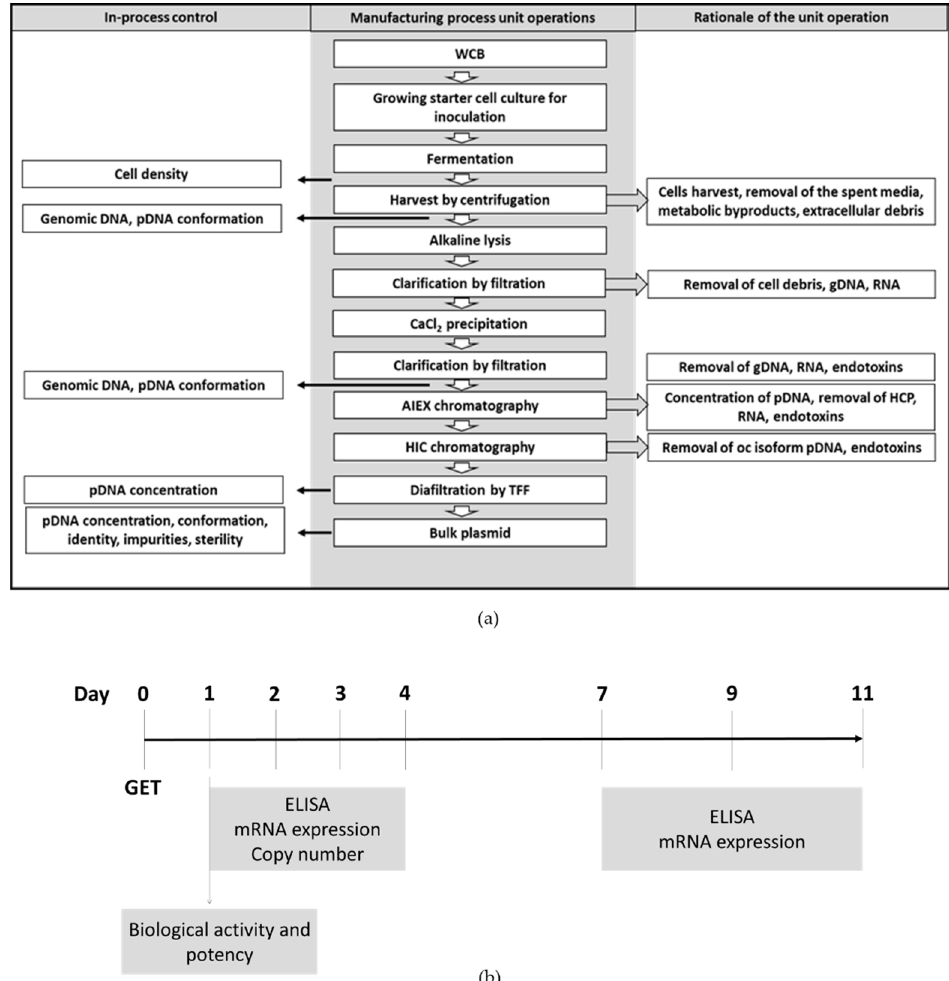
Figure 1. Designated study protocols. ( a ) Manufacturing process flowchart for phIL12 and pmIL12 production with unit operations and the in-process control sequence. ( b ) Timeline of the in vitro experiments.